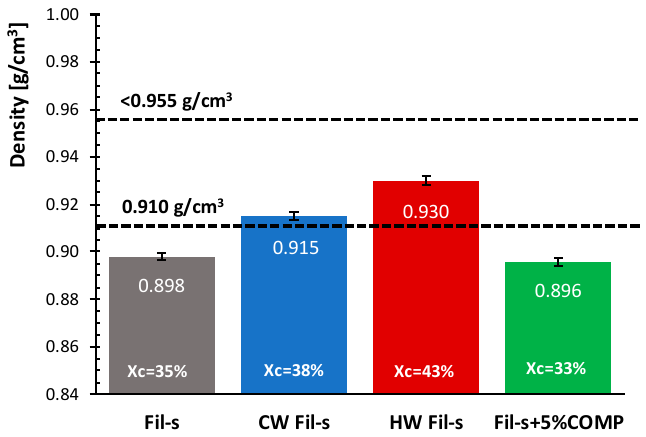
Figure 7. Comparison of the density ( ρ ) values for the analysed Fil-s based systems. The data relative to the first and last “ ρ class”, as defined in ASTM D3350 standard, are also reported. By comparing the density data of the unwashed and washed Fil-s samples, a higher density is observed for these latter, which coherently correlates with an increase in the crystallinity degree for the recyclate following the washing treatments. On the other hand, the addition of the compatibilizer does not involve a significant change in Fil-s density, in agreement with the DSC thermal results, which highlight only a slight reduction in the crystallinity degree for the compatibilized recyclate.